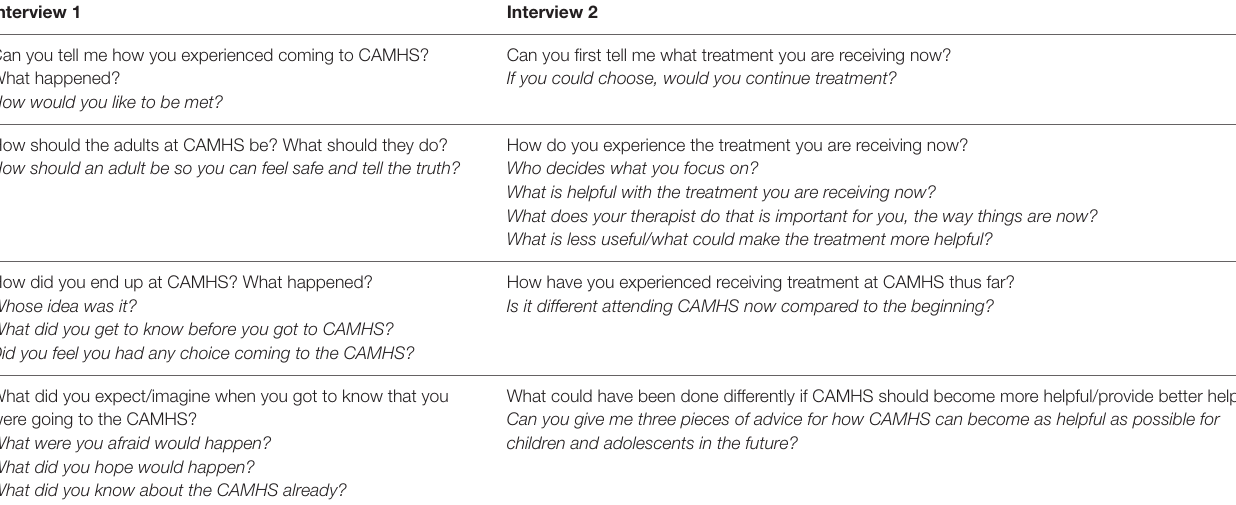
TABLE 1 | Interview guide for the two interviews with the adolescents, developed in cooperation with young people in the user organization Forandringsfabrikken. Interview 1 Interview